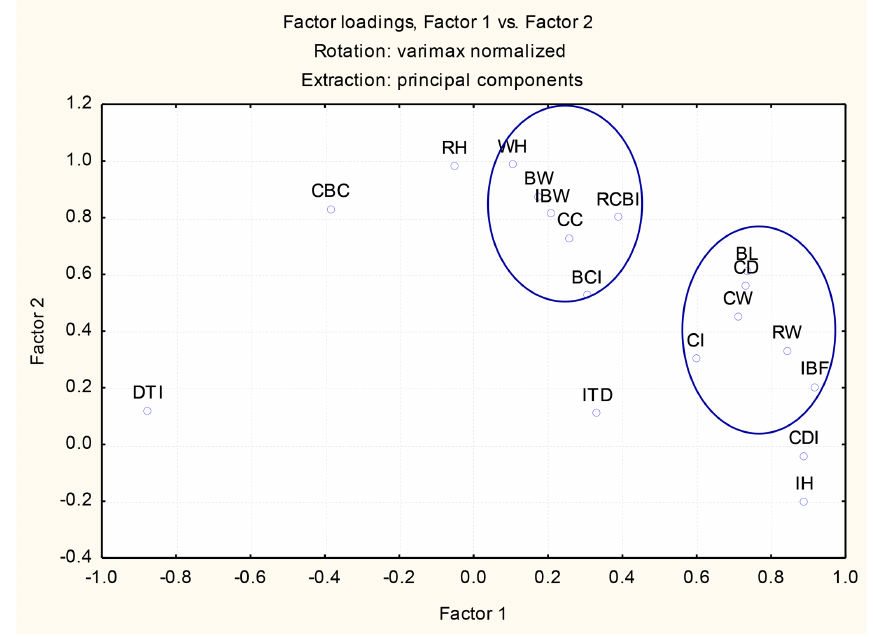
Figure 2. Scatter plot of the principal component analysis (Factor 1 vs. Factor 2). Table 5. Euclidean distances among six sheep breeds based on morphological measurements and indices. Istrian Bela Bardoka Pivska Sjeniˇcka Zeta Pramenka Krajina Pramenka Žuja Istrska Pramenka 0.00 Bela Krajina 3.72 0.00 Bardoka 5.58 4.70 0.00 Pivska Pramenka 4.97 5.27 4.63 0.00 Sjeniˇcka 4.54 5.50 5.20 1.87 0.00 Zeta Žuja 8.67 8.38 4.89 8.34 8.87